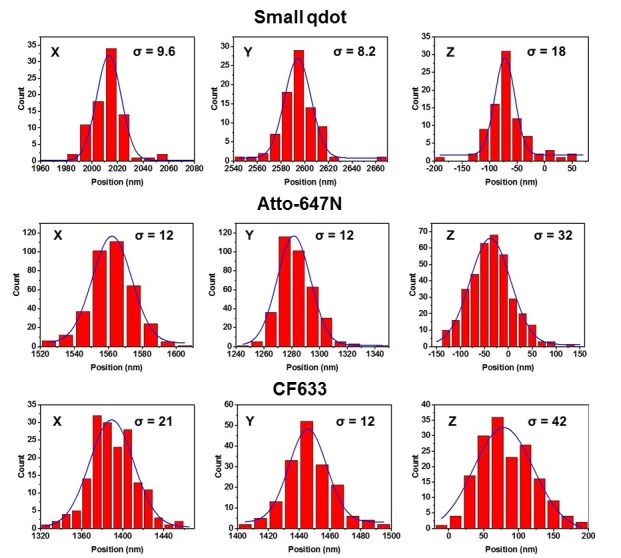
The precision of each fluorophores.The histograms were obtained from the localization particles over 200 frames with 50 ms exposure time. All these measurements were done with astigmatism for 3D using a cylindrical lens.